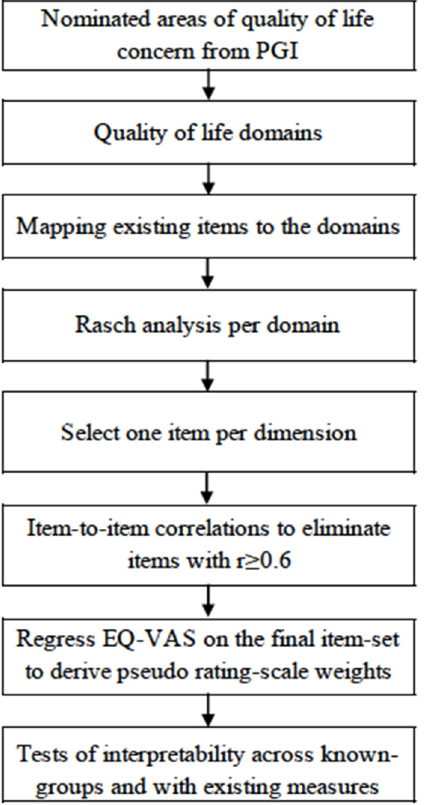
Figure 1. Steps to developing HIV-HRQL measure.